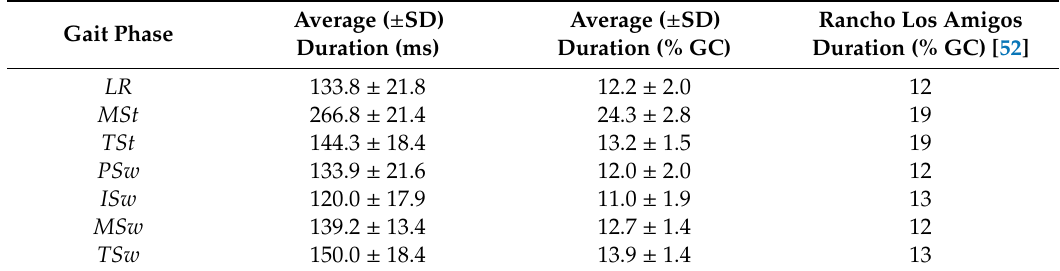
Table 2. Average ( ± SD) gait phase duration during walking in typically-developing children. Subject specific phase duration was used to calculate the trigger percent delay for each gait